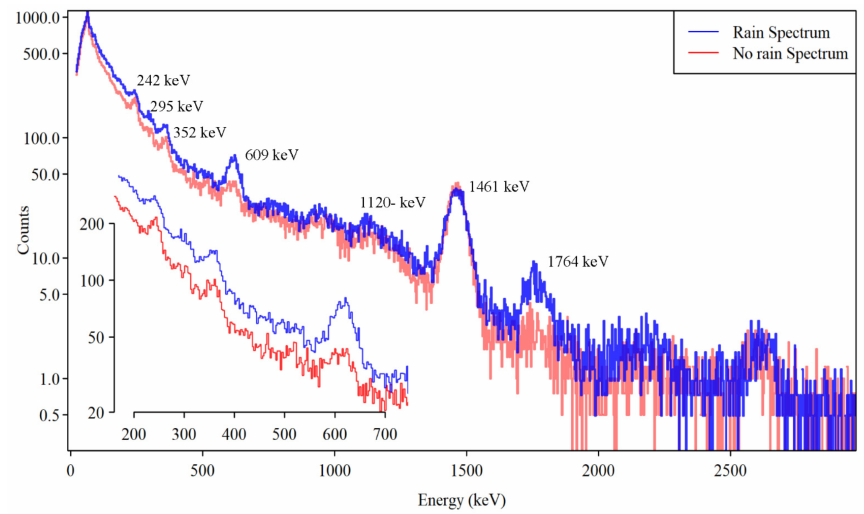
Figure A1. Representative gamma-ray spectra obtained before (red line) and during (blue line) the rainfall events of 9 October 2016. On the inset subplot, the energy range 150–750 keV is magnified to show the absence of 7 Be 477 keV photo-peak from the spectrum during